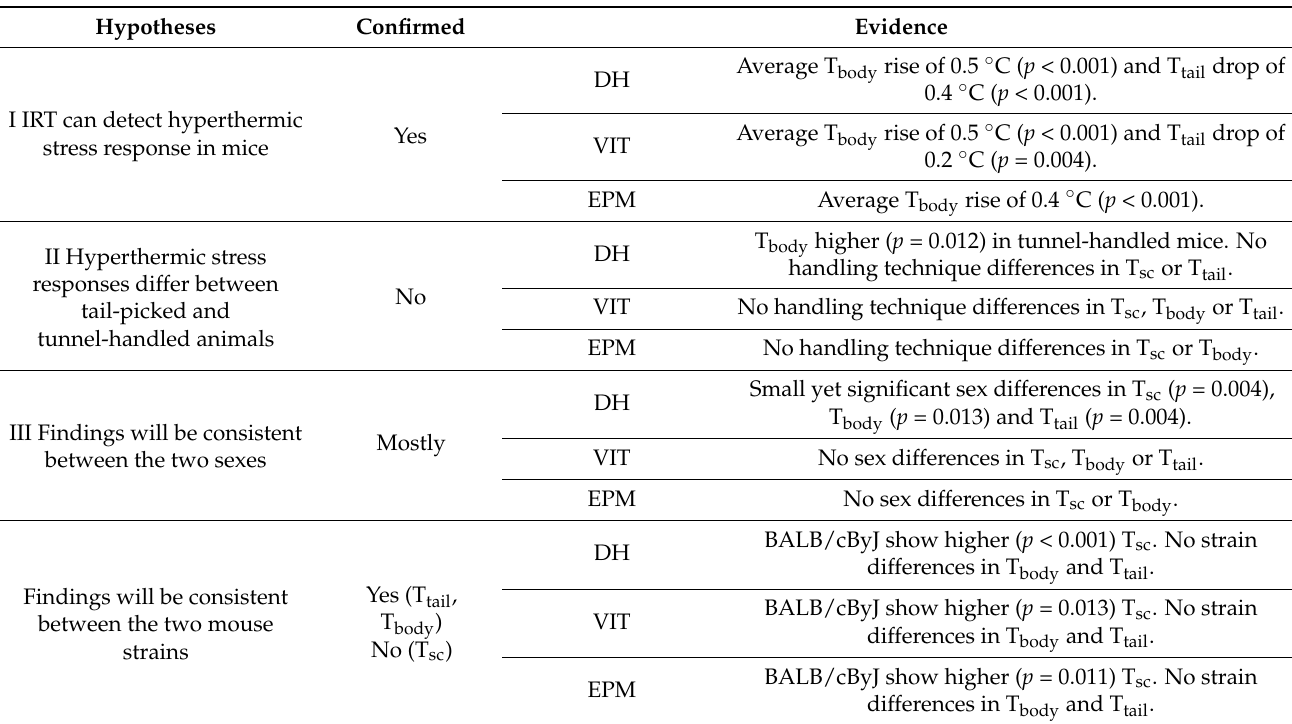
Table 1. Summary of the results in relation to the specific hypotheses (stress-induced hyperthermia (SIH), infrared thermography (IRT), temperature from subcutaneously-implanted thermosensitive PIT-tags (T sc ), mean body surface temperature measured with IRT (T body ), mean tail surface tempera- ture measured with IRT (T tail ), Daily Handling (DH), Voluntary Interaction Test (VIT) and Elevated Plus Maze